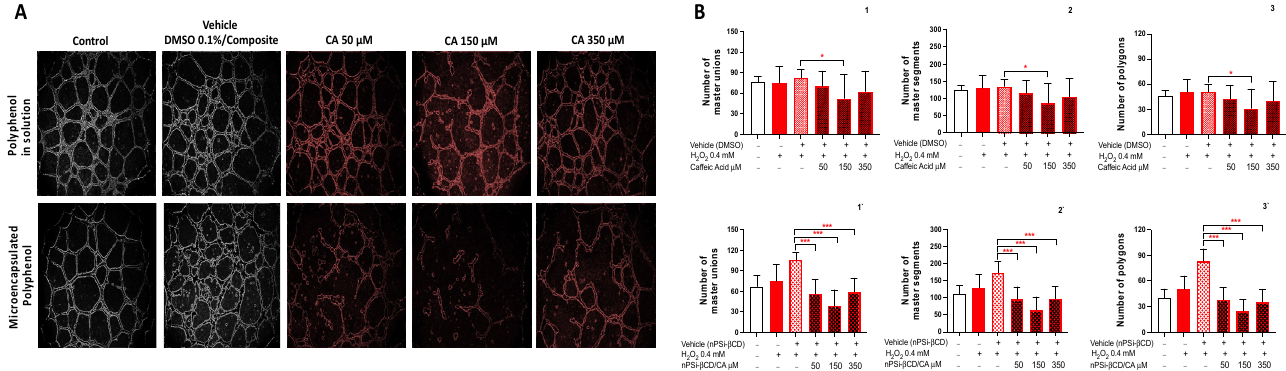
Figure 6. Effect of treatment with caffeic acid in solution and loaded in the nPSi- β CD composite microparticle on the ability of HUVECs to form tubular structures in Matrigel. ( A ) The images were taken at 8 h and are representative for each treatment group. ( B ) Effect quantification of treatment with caffeic acid in solution and loaded in the nPSi- β CD composite microparticle on the ability of HUVECs to form tubular structures in Matrigel. ( 1 , 1` ) number of master unions, ( 2 , 2` ) number of master segments, and ( 3 , 3` ) number of polygons formed. The numbers 1, 2, and 3 correspond to the polyphenol in solution, while 1`, 2`, and 3` correspond to the microencapsulated polyphenol. Statistically significant differences are indicated compared to the control treatment (vehicle). (* = p < 0.05; *** = p < 0.001; n = 3).